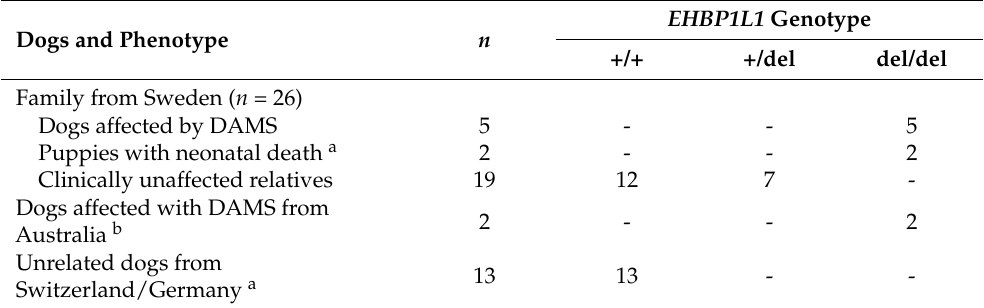
Figure 6. Sanger sequencing chromatograms surrounding the EHBP1L1 :c.3120delC variant and the amino acid sequence of a wild type and an English springer spaniel with DAMS. A homozygous deletion of a single cytosine is visible in the affected dog, resulting in a frameshift with an early stop codon. Table 6. Genotype–phenotype association in the EHBP1L1 :c.3120delC variant with DAMS and neonatal death in 41 English springer spaniel